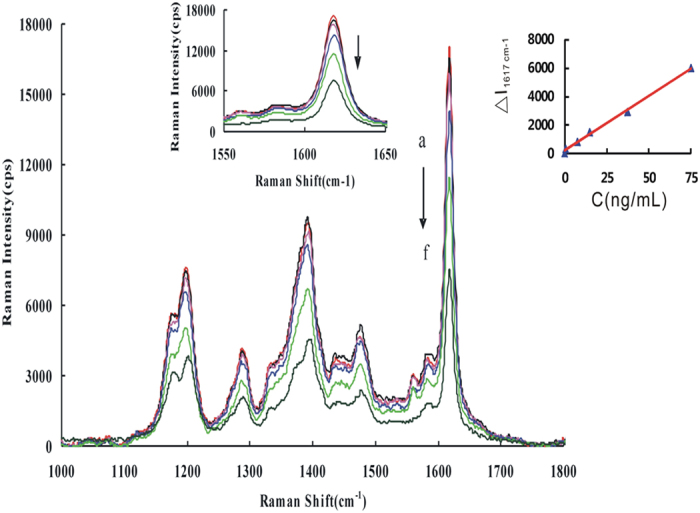
SERS of Au/AuNPs-HS-VB4r-FeCl3 System.(a) pH 4.0 20 mmoL/L NaAc-HAc + 0.1 μmoL/L VB4r + 0.195 mmoL/L Au/AuNPs + 1.5 μmoL/L FeCl3; (b) a + 0.5 ng/mL HS; (c) a + 5 ng/mL HS; (d) a + 50 ng/mL HS; (e) a + 100 ng/mL HS; (f) a + 150 ng/mL HS.